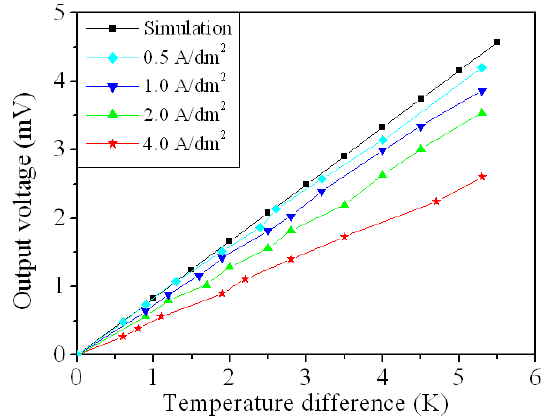
Figure 10. Output voltage of the flexible thermoelectric generator at different current density.